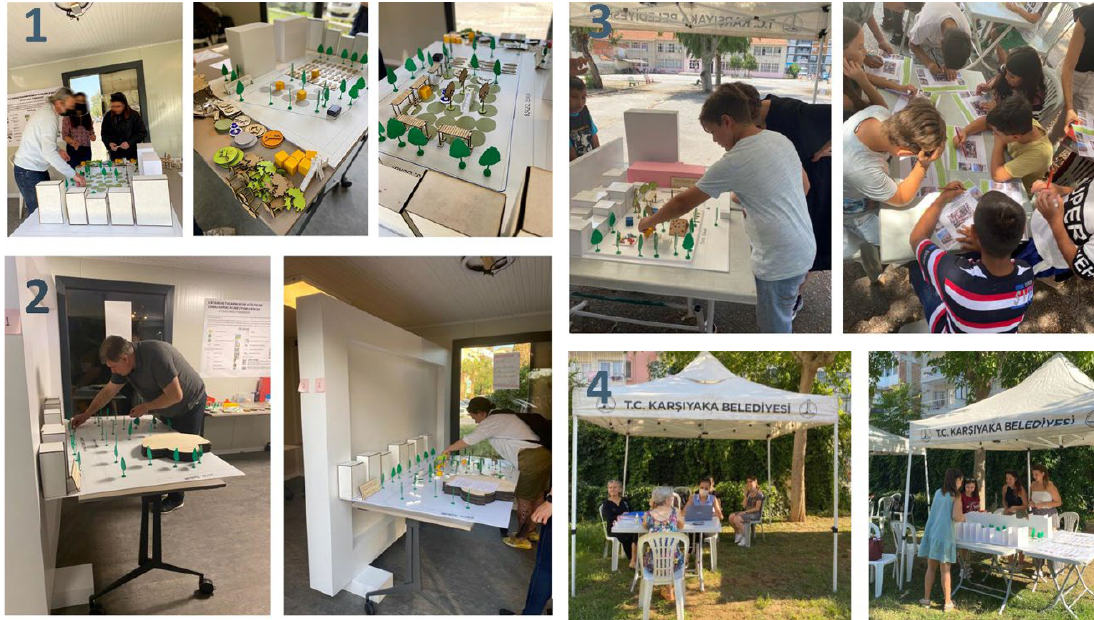
Figure 6 Citizen Design Science Workshops-Izmir: (1 ) Atakent Car park, (2) Cemal Gürsel Street, (3) Bahariye-Bahar Park, (4) Şehit Ast. Erkan Durukan Primary